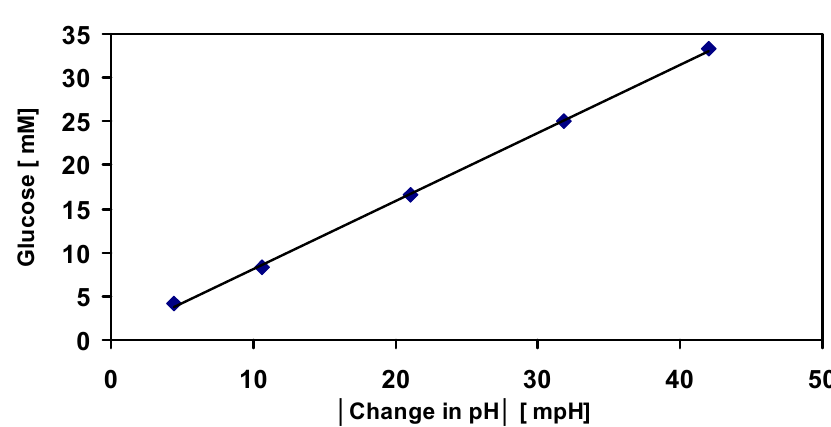
Figure 13. Calibration curve for the glucose concentration. Different glucose standards (4.4–42 mM)